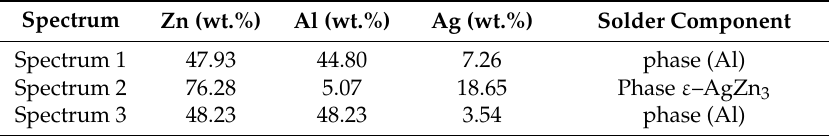
Figure 10. EDX point analysis of bond in the boundary of MMC / Zn6Al6Ag joint, the zone with a new composite. Table 5. The phase composition of MMC / Zn6Al6Ag joint